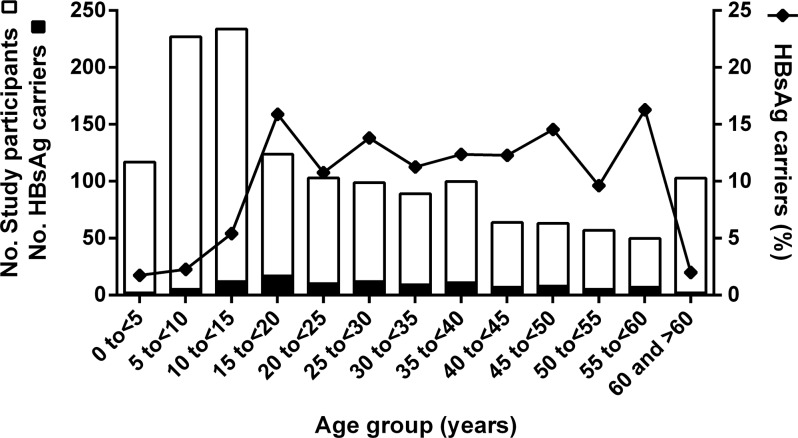
Age distribution and percentage of HBsAg carriers.A stacked graph of the total number of study participants for each age group (white bar) and of the corresponding number of HBsAg carriers (black bar) (left y-axis) is shown. The percentage of HBsAg carriers for each age group (right y-axis) is indicated by squares.